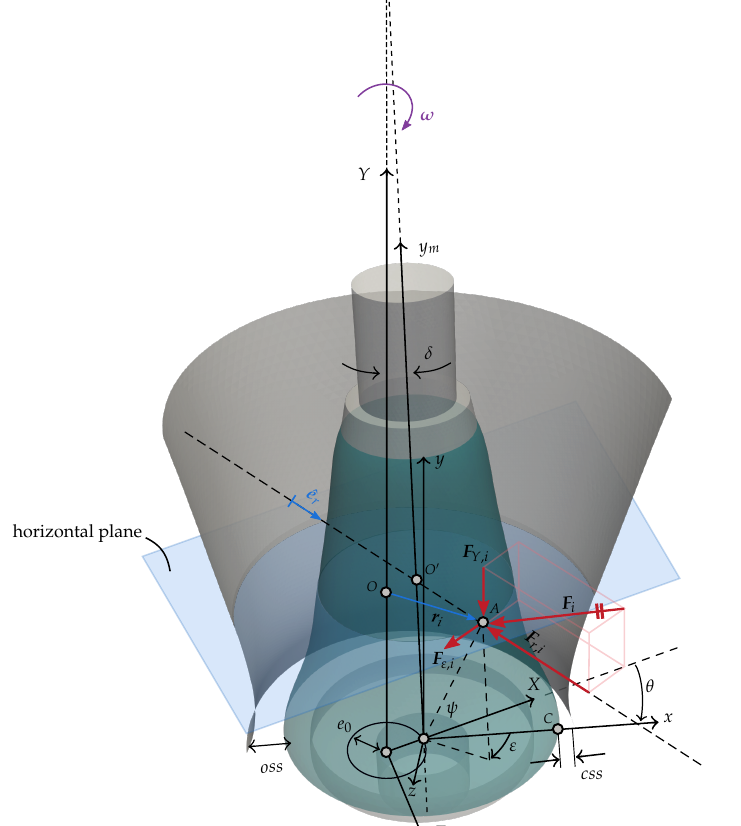
Figure 2. Geometric parameters of the gyratory crusher, force decomposition, and moving frame of reference. Tilt angle, γ ; pivot point Q , eccentricity at the base of the mantle, e 0 ; open side setting, oss ; closed side setting, css ; axial axis of the main shaft, y m ; the fixed XYZ and moving frame of reference xyz ; are presented for the simulation time t , such that θ = ω t . A force F i is applied in point A , showing their radial, F r , i , transverse, F ε , i , and vertical, F Y , i , components. The position of A is represented r i , ε and ψ , and the radial direction is represented by ˆ e r . Both points O and O 0 belongs to the horizontal plane.